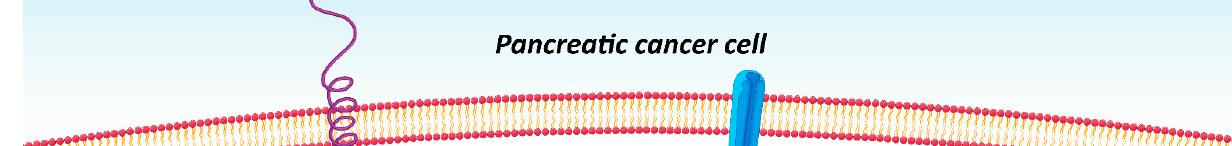
Figure 3. Suppressing PC metastasis and increasing their sensitivity to chemotherapy. By disrupting cancer proliferation and metastasis, as well as triggering apoptotic cell death, an increase occurs in sensitivity of PC cells to chemotherapy. SiRNAs play an important role in mediating these anticancer effects. MMp-2, matrix melloproteinase-2; hnRNP A2/B1, heterogeneous nuclear ribonucleoprotein A2/B1; TGF- β , transforming growth factor-beta; VEGF, vascular endothelial growth factor; COX-2, cyclooxygenase-2; GEM, gemcitabine; NF- κ B, nuclear factor-kappaB; DOX, doxorubicin, siRNA, small interfering RNA; PC, prostate cancer. Table 2. Interference with PC progression via application of siRNAs. In Vitro/In